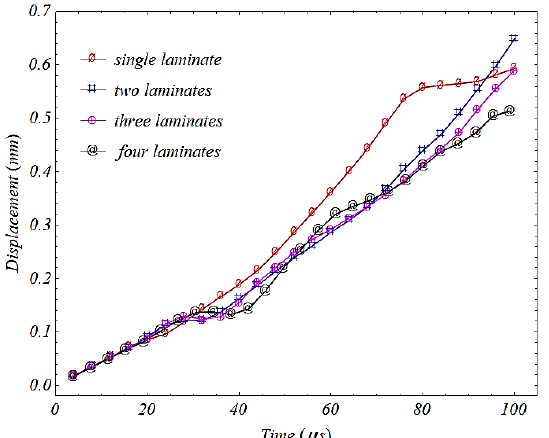
Fig. 26. Displacement against time for various number of cellphone casing laminates at 1000mm drop distance.